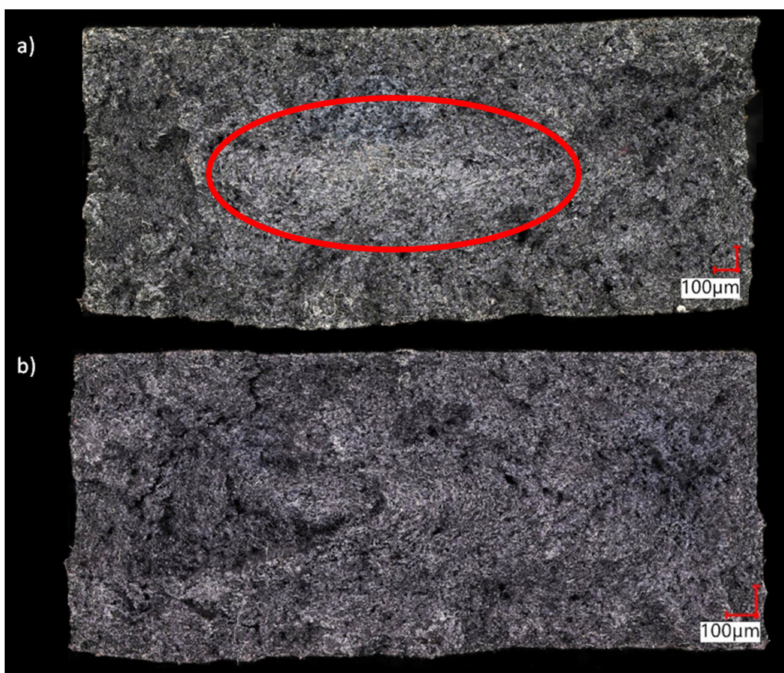
Figure 8. The fractures of the PA66 GF30 samples with a thickness of 8.4 mm obtained in the static tensile test: ( a ) unfoamed sample A, ( b ) sample C foamed with nitrogen at the pressure of 20